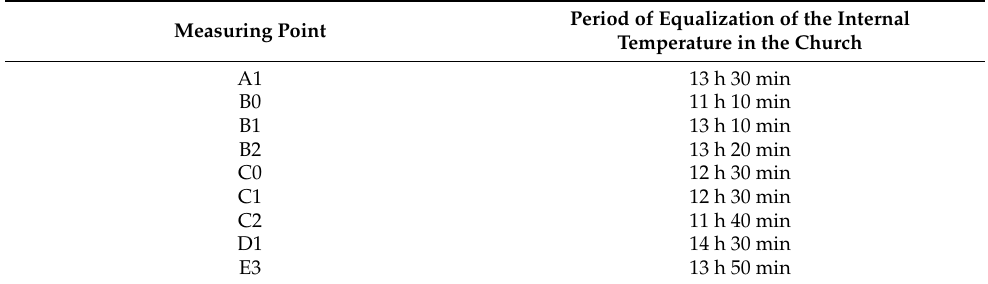
Table 2. The effect of worship service on the formation of internal temperature in the church, during summer (298 people, 20 May